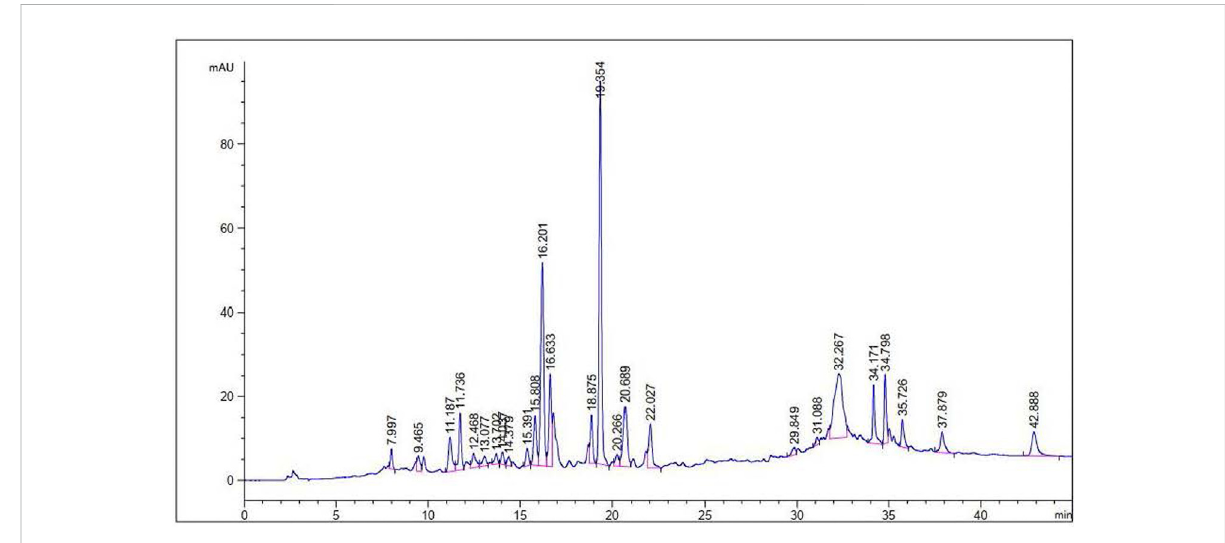
FIGURE 2 HPLC chromatogram representing phenolic pro fi le of the leaf extract of P. gemini fl orum